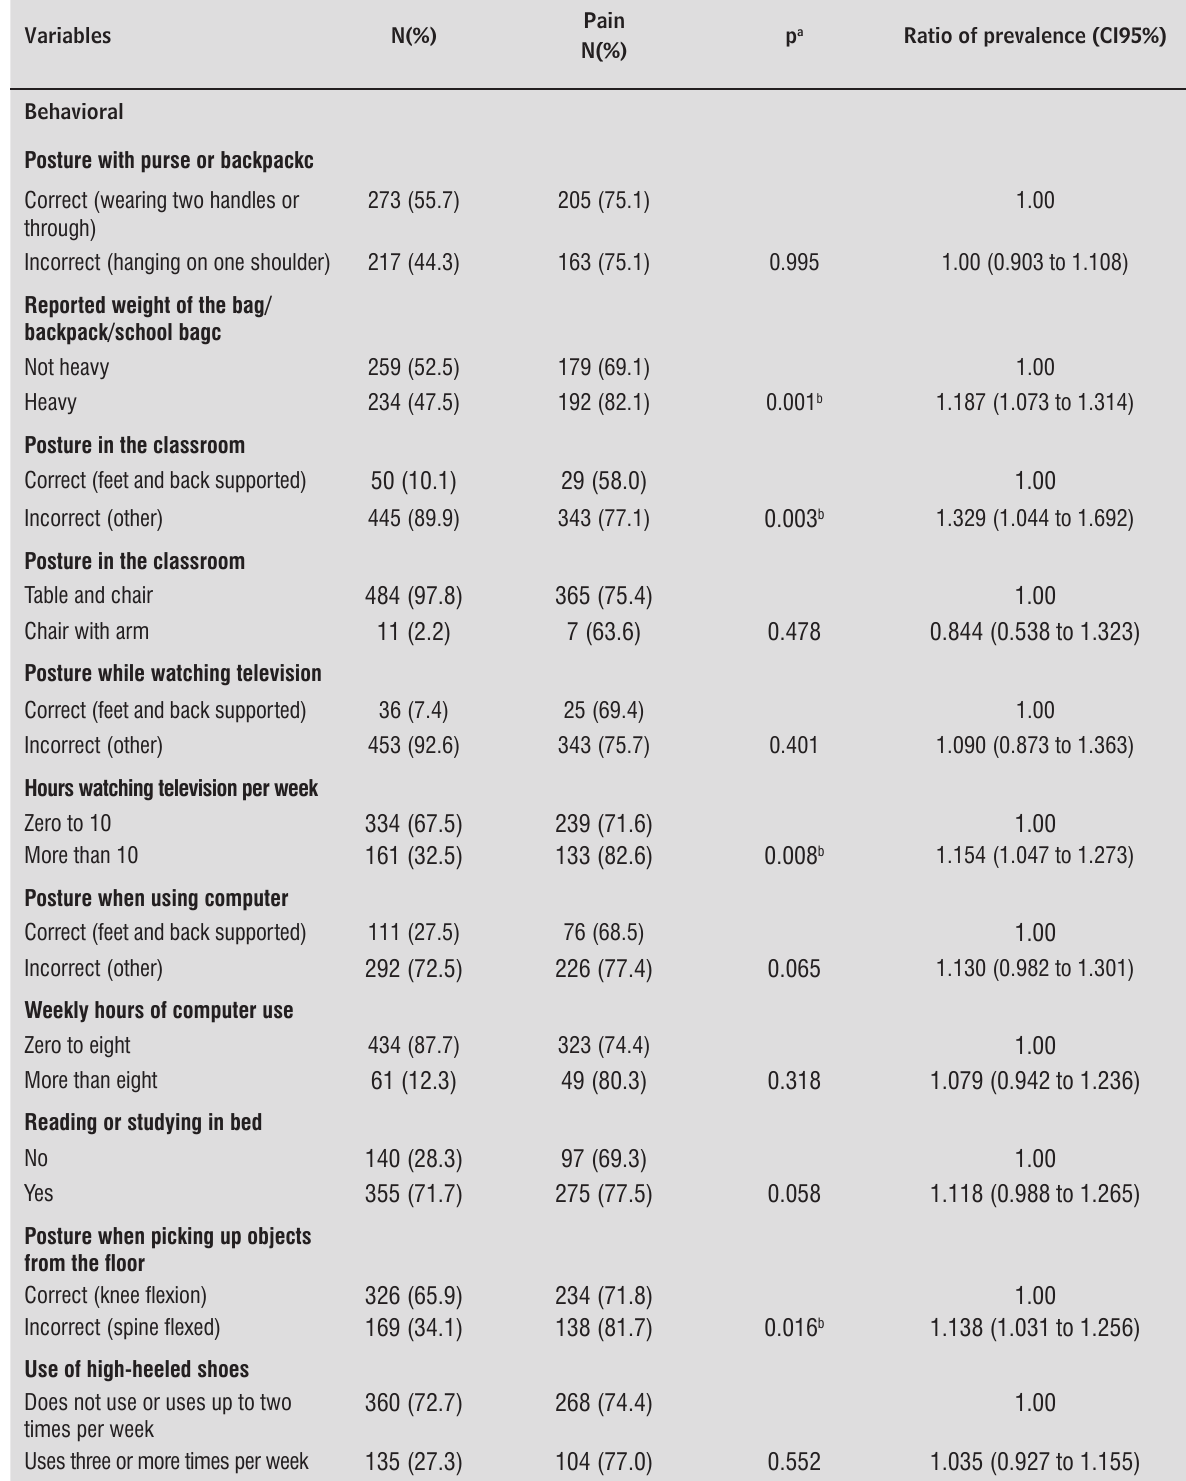
Table 2 - Prevalence of back pain and socioeconomic, demographic and anthropometric variables in female students aged 14 to 18 years, São Leopoldo, Rio Grande do Sul, Brazil, 2004 Pain Variables N (%) Ratio of prevalence (CI95 %